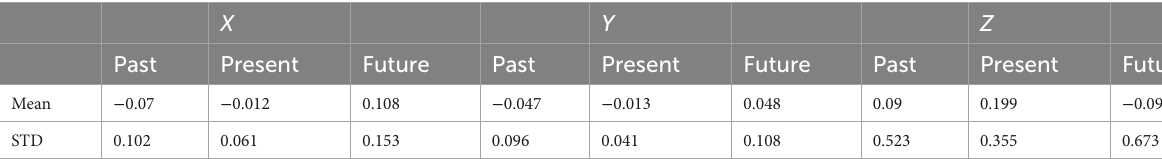
TABLE 3 Mean and STD values of X , Y , and Z